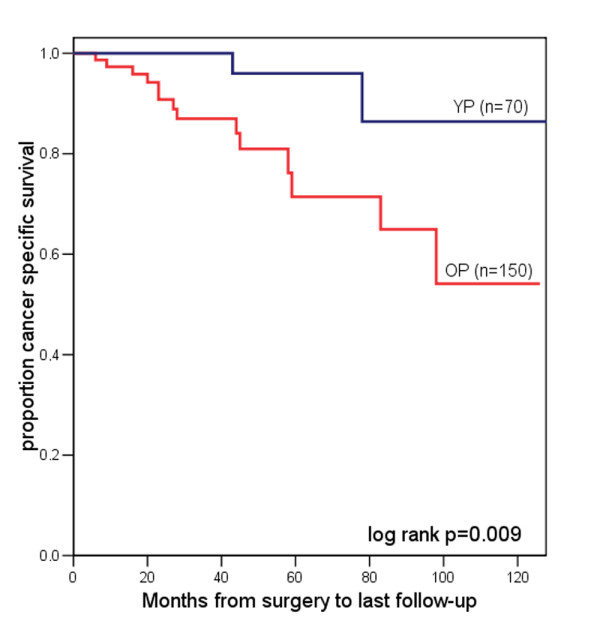
Kaplan-Meier analysis of cancer specific survival for YP (= blue line) vs. OP (= red line) with RCC.